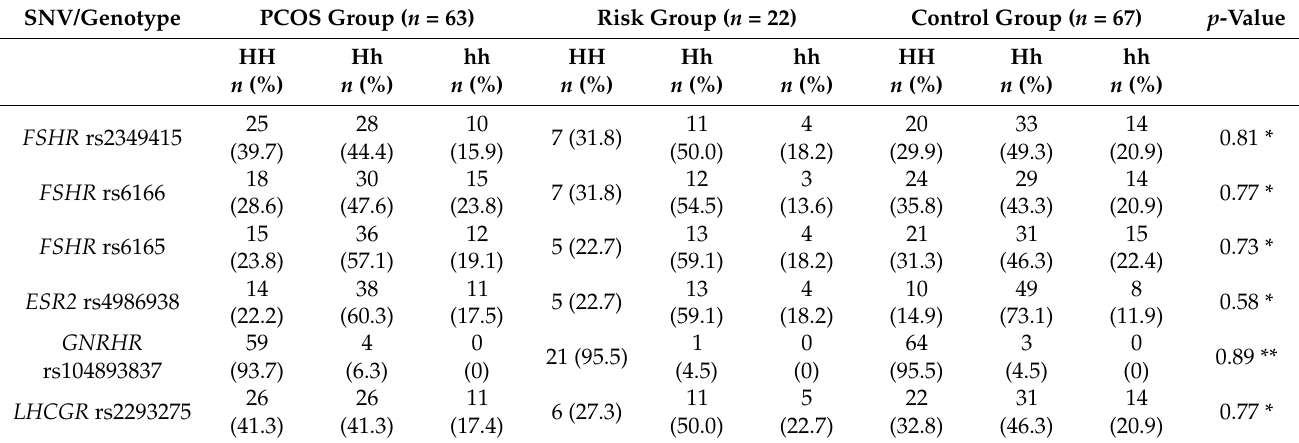
Table 2. Genotype frequencies of the six SNVs in the PCOS, risk and control